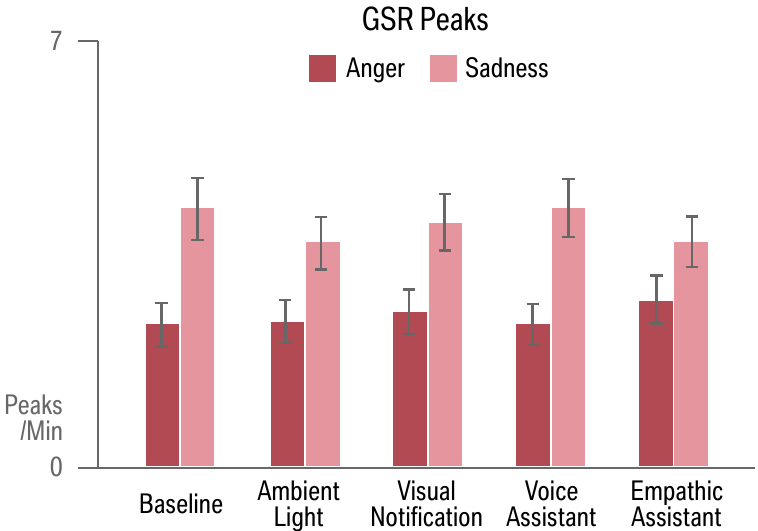
Figure 8. GSR peaks per minute during interaction periods. Sadness produces more peaks than anger. Strategy Empathic Assistant manages to adjust peak counts in both groups.